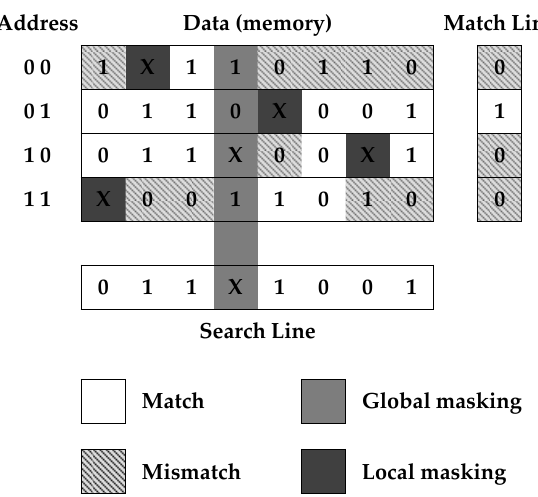
Figure 5. Local and global masking of a TCAM [28].